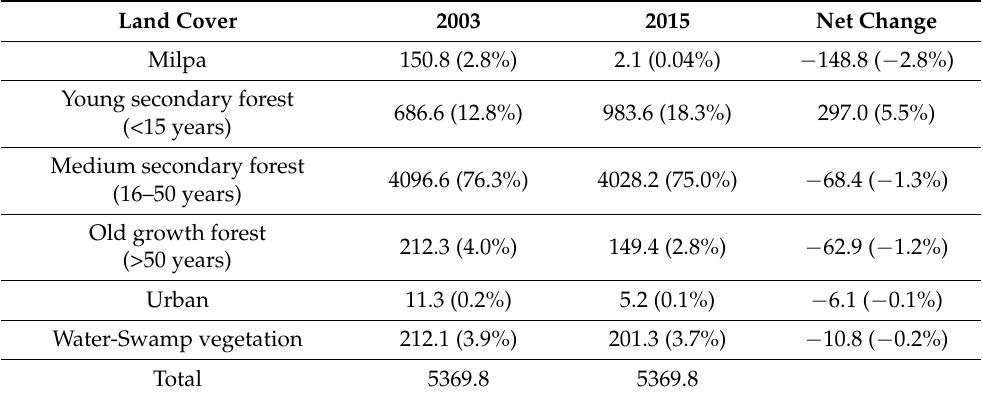
Table 1. Cover classes in area (ha) and percentage (in parenthesis) within OMKY before (2003) and after (2015) the PA